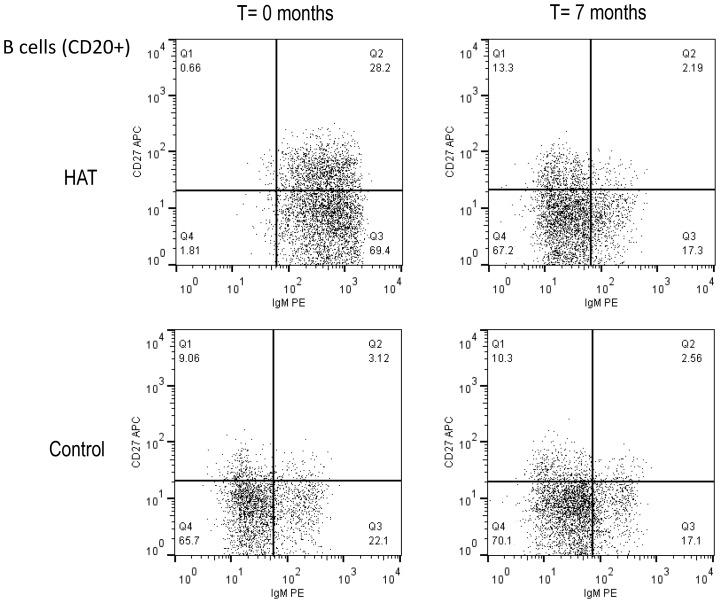
Flow cytometry dot plot of the CD20+ B-cell population in HAT and in a control.B-cell subsets were based on the CD27 and IgM cell surface markers. A HAT patient before and after treatment (T = 0 and 7 months), and a healthy control subject at the same time points are shown. Cut-offs for considering a cell surface marker positive or negative were based on isotype controls and are shown as solid lines, and subdivide the graph into 4 quadrants (Q1–Q4). B-cell subsets in each quadrant are expressed as percentages of CD20+ B-cells.